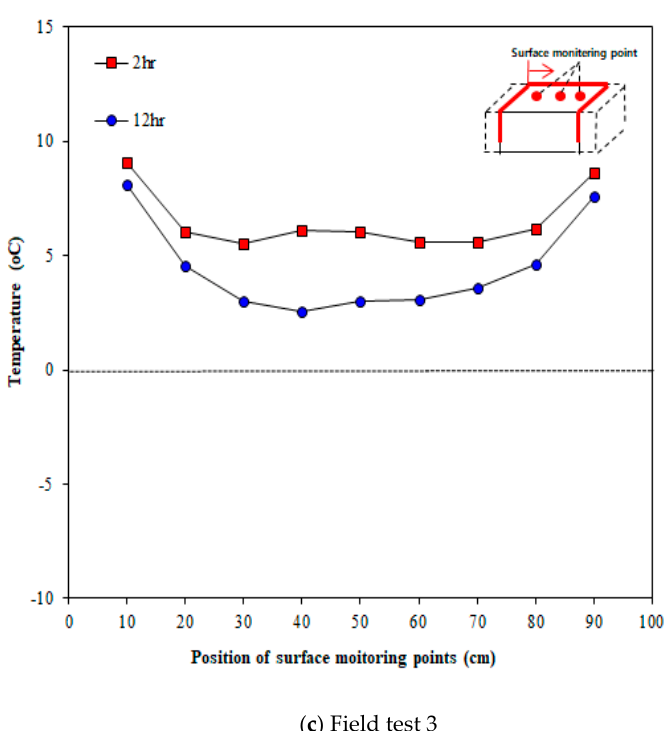
Figure 13. Temperatures at different surface locations and measurement times (Line 1).